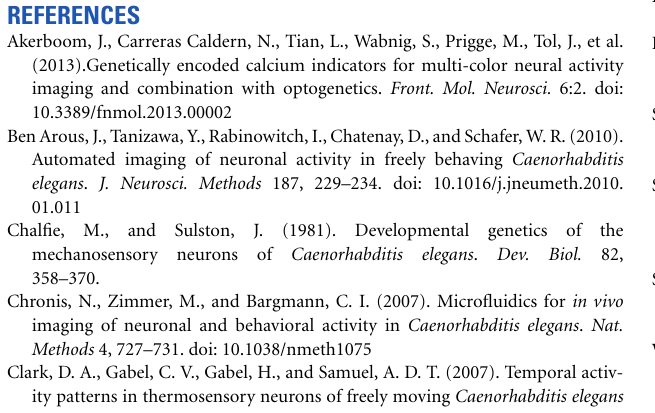
Figure 2B . (cid:3) R / R 0 is calculated as before, but with GFP fluorescence instead of GCaMP3. Because GFP is insensitive to modest changes in calcium levels, fluctuations in the signal observed here is presumably due to motion artifact or instrument